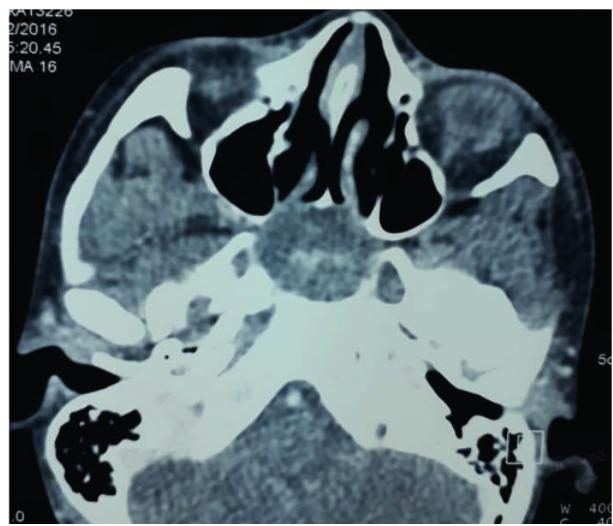
choana.Figure 1. Endoscopie view (Opties 0 0 ) of the hemangioma externalized by the choana.